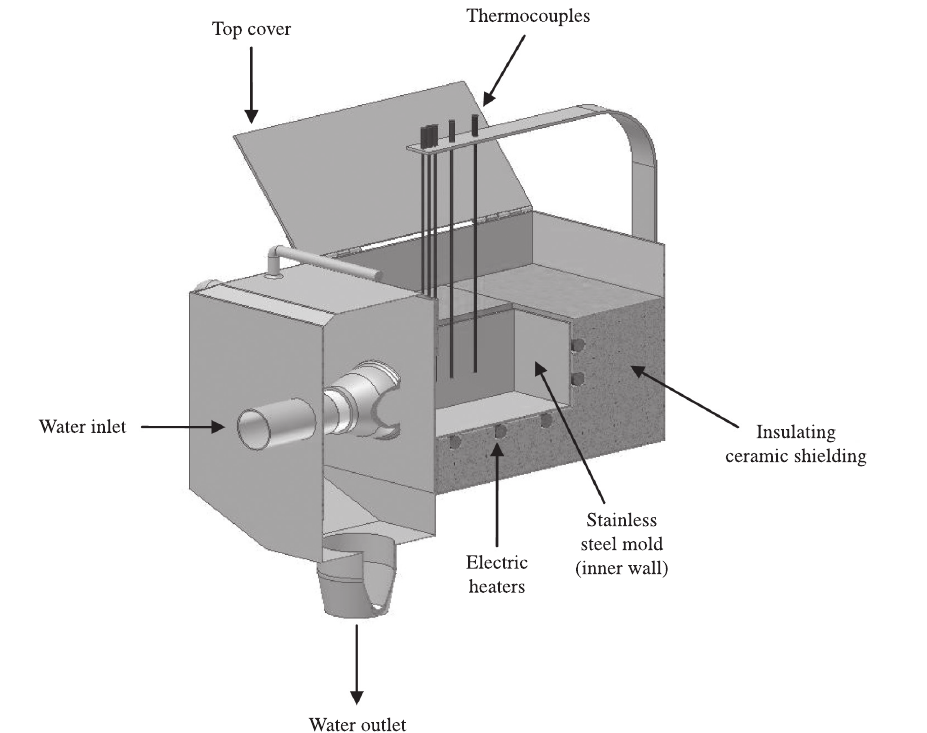
Figure 1. Furnace schematic showing thermocouples located at different positions from the metal-cooling chamber interface.